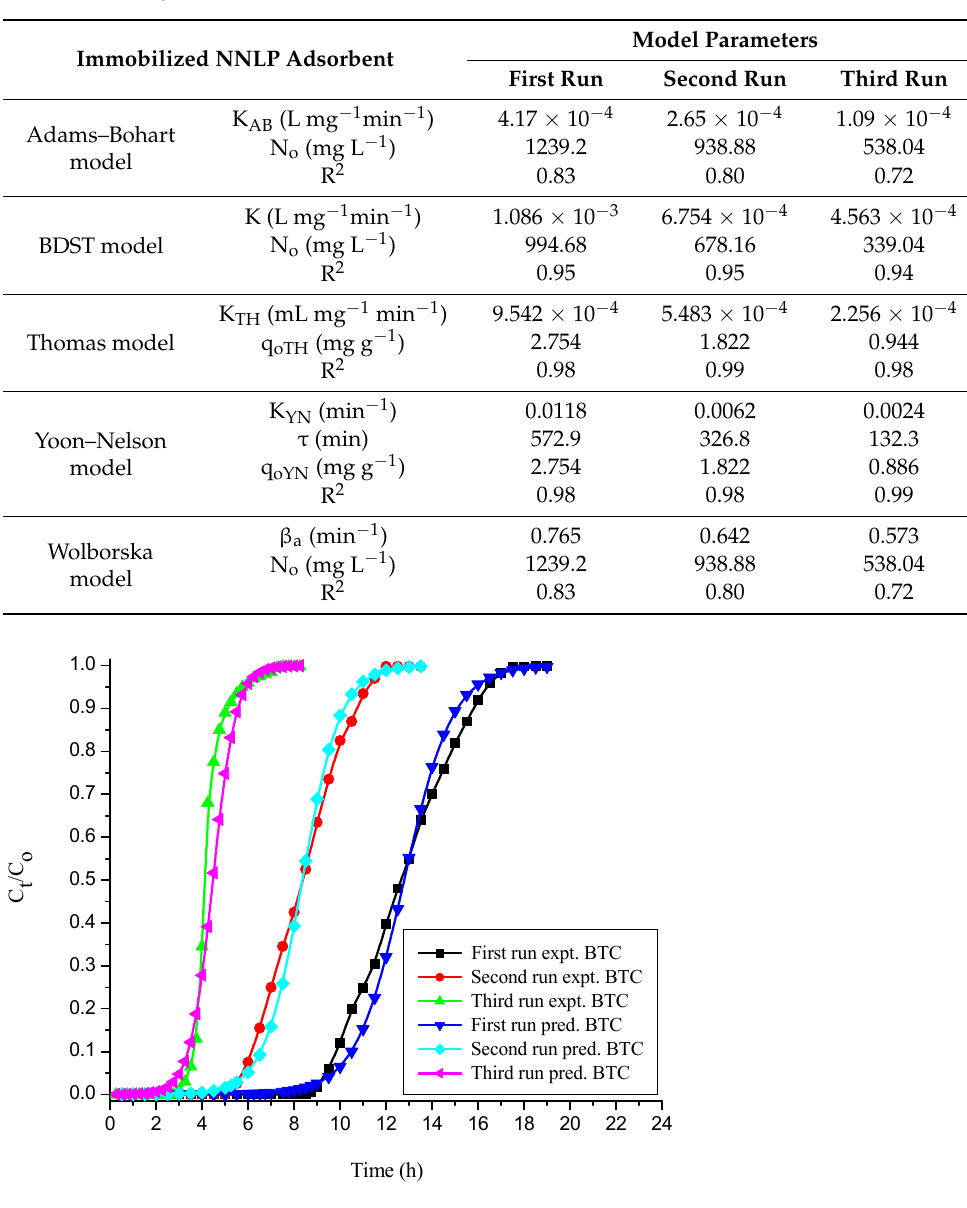
Figure 6. BTCs for experimental vs. simulated Thomas model for the decolorization of CR by free NNLP adsorbent in various runs. (Initial pH: 6; flow rate: 1 mL min − 1 ; inlet dye concentration: 15 mg L − 1 ; temperature: 301 K)